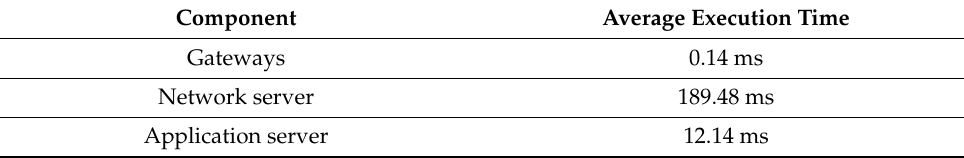
Table 1. Average Execution Time of the Fog Components for 1000 Requests.